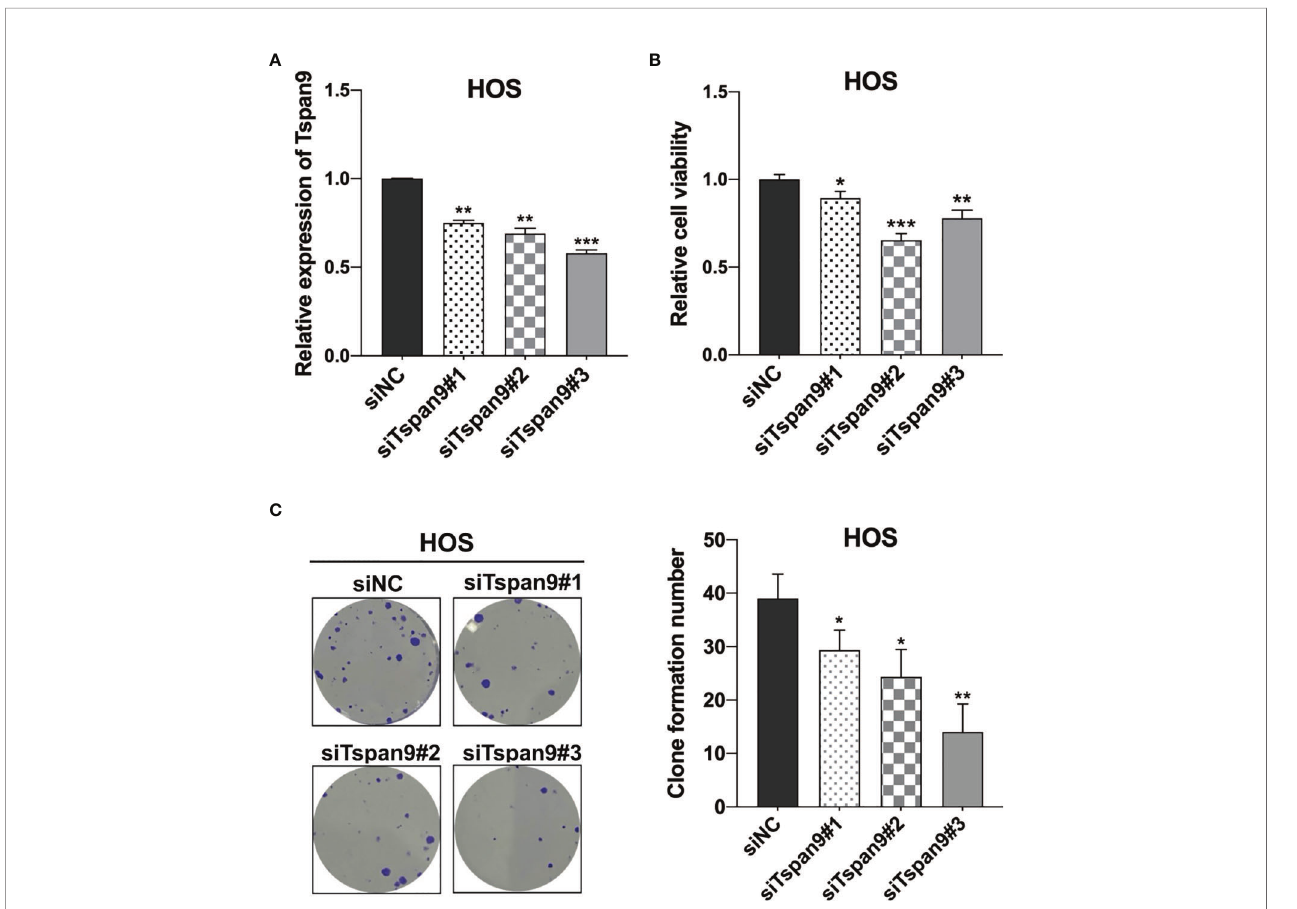
FIGURE 2 | Tspan9 knockdown suppresses OS cell proliferation. (A) Tspan9 mRNA levels in siTspan9 cells (siTspan9#1, #2, and #3) were signi fi cantly lower than those in siNC cells, as measured via qRT-PCR. (B) The viability of HOS cells in the siNC and siTspan9 HOS cells was assessed via CCK-8 assay. (C) The impact of Tspan9 knockdown on HOS cell proliferation was measured via colony formation assay. Statistical results of colony formation numbers normalized to shNC were presented. * P < 0.05; ** P < 0.01; *** P < 0.001; Student ’ s t-test. NC, negative control; si, small interfering